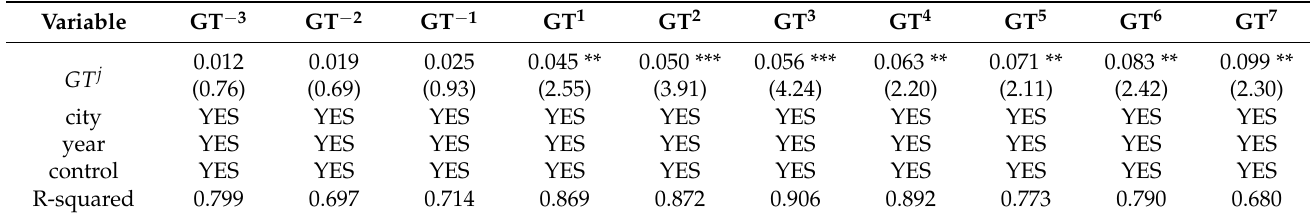
Table 8. Time effect analysis of GZR urban innovation dividend (capital level).